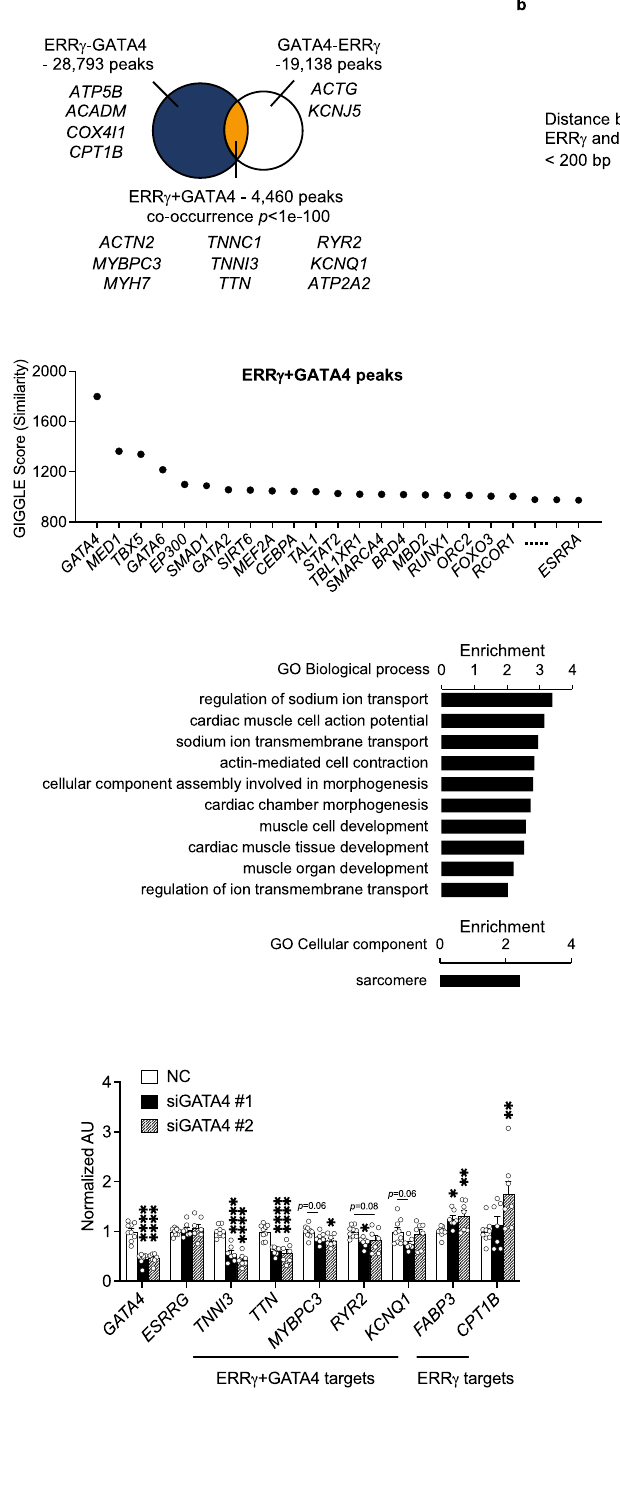
downregulated (Fig. 7b). PPARGC1A de fi ciency also resulted in downregulation of most GATA4-independent ERR targets involved in mitochondrial metabolism such as ATP5B 44 and ACADM 45 (Fig. 7b). Moreover, depletion of PPARGC1A expres- sion resulted in a signi fi cant reduction in ERR γ occupation on cardiac-enriched target regulatory regions and metabolic genes